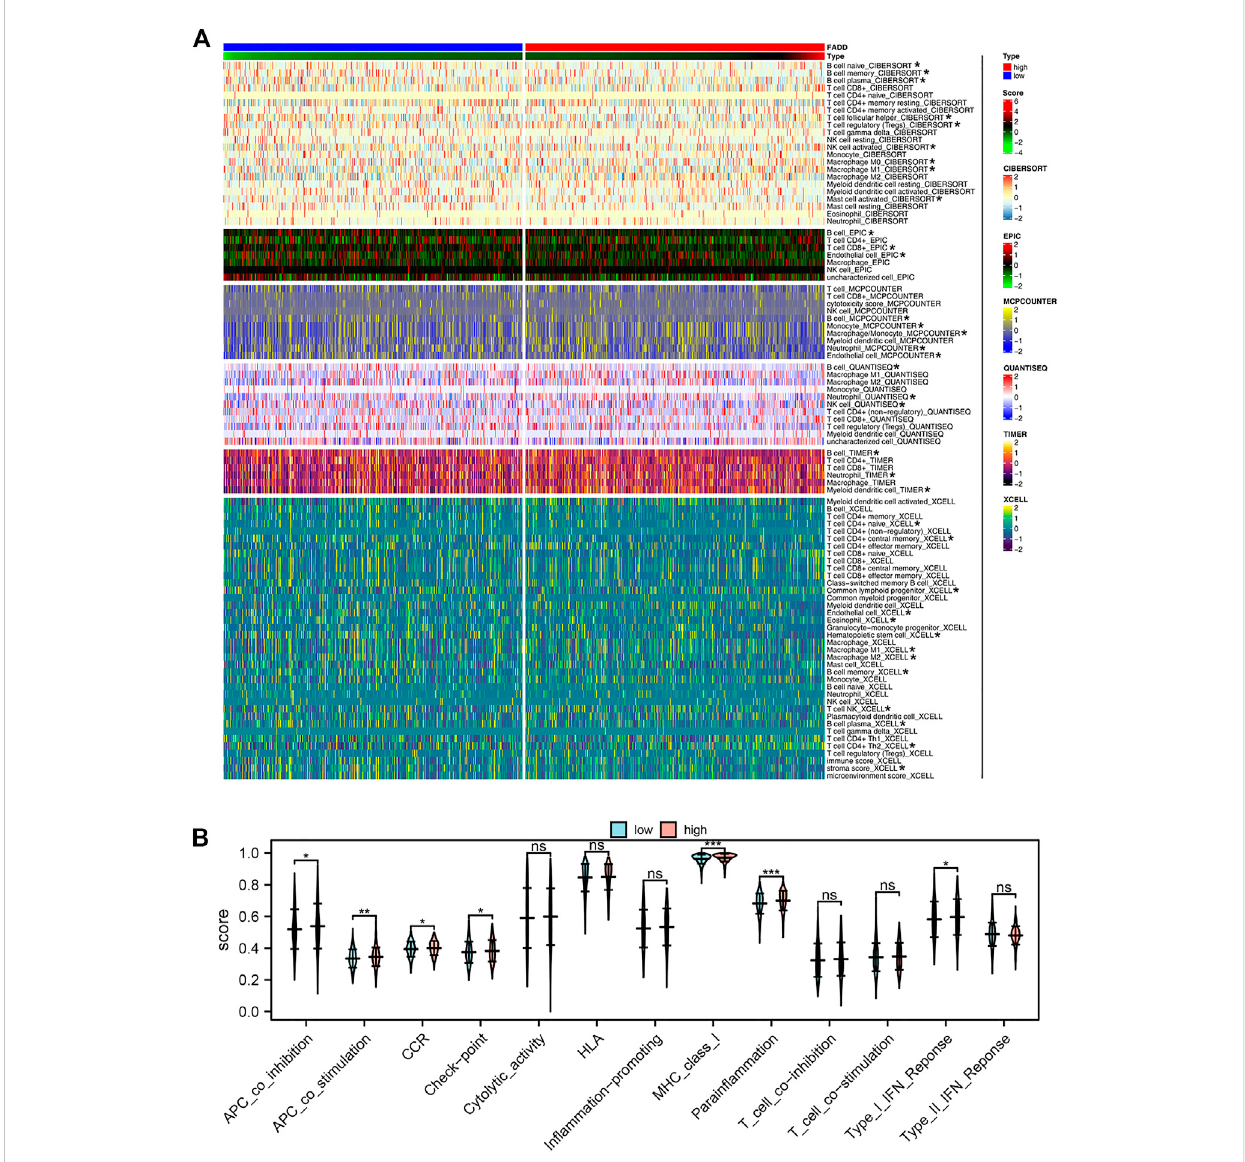
FIGURE 4 Effect of FADD on immune in fi ltration and function. Notes: (A) The correlation between quanti fi ed immune cells and FADD; (B) The activity of multiple immune functions in high- and low-FADD expression patients.